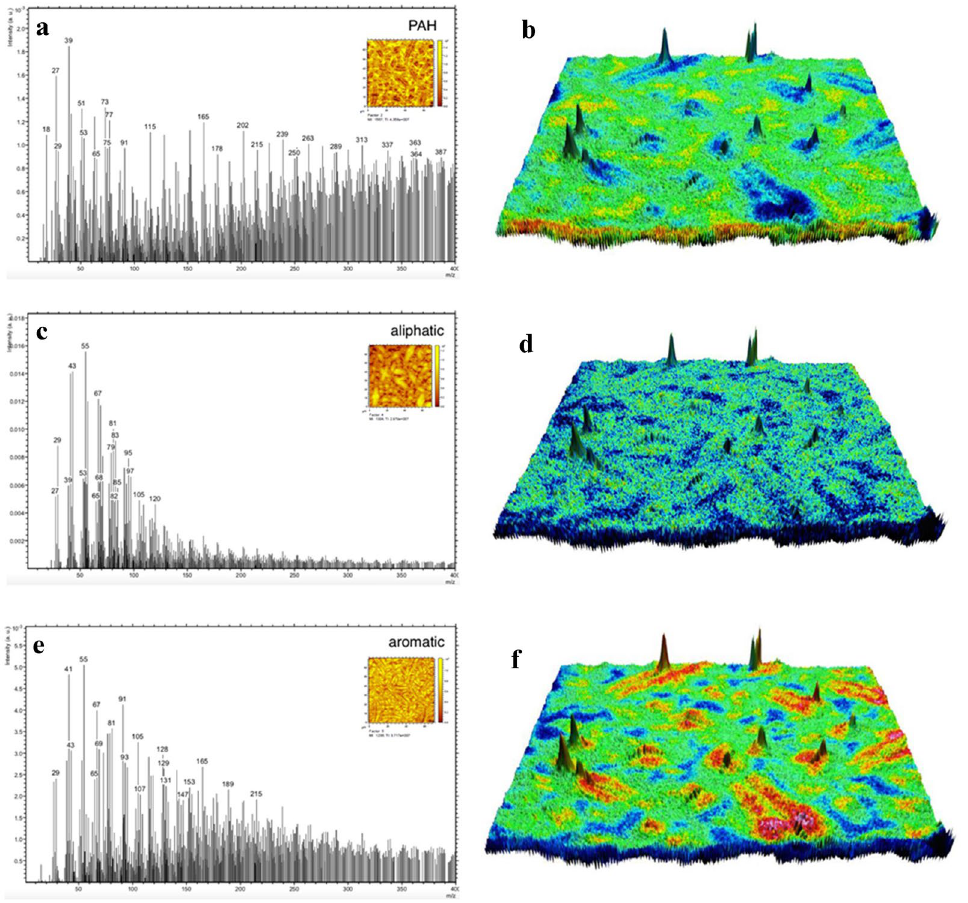
Figure 6. ToF–SIMS spectrum contributing to the ToF–SIMS image with resulting AFM-ToF–SIMS carpet plot images. ( a ) ToF–SIMS loadings spectrum correlated to polycyclic aromatic hydrocarbons which contributes to the SIMS score image on the top right corner, ( b ) AFM correlative ToF–SIMS carpet plot of high mass aromatic compounds. Here, red, green and blue areas indicate high, medium and low concentrations, respectively, ( c ) ToF–SIMS loadings spectrum correlated to aliphatic structures, which contributes to the SIMS score image on the top right corner, ( d ) AFM correlative ToF–SIMS carpet plot of combined aliphatic compounds, ( e ) ToF–SIMS loadings spectrum of combined aromatics which contributes to the SIMS score image on the top right corner, ( f ) AFM correlative ToF–SIMS carpet plot of combined aromatics. SIMS images—field of view: 54 × 54 µm 2 . Images created using SurfaceLab7 software. https:// www. iontof. com/ m6- tof- sims- techn ical- detai ls. html#